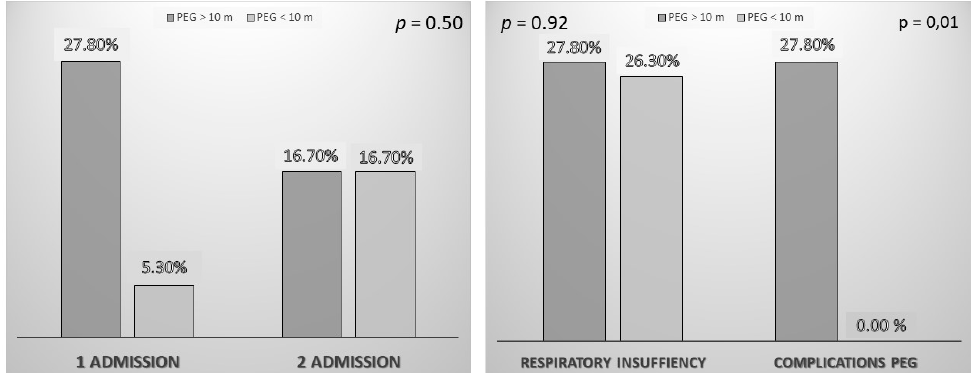
Figure 3. Differences in the percentage of admissions and the cause of admissions depending on the implantation of PEG (percutaneous endoscopic gastrostomy) before (PEG < 10 months) or after (PEG > 10 months) 10 months from the diagnosis of ALS (amyotrophic lateral sclerosis).